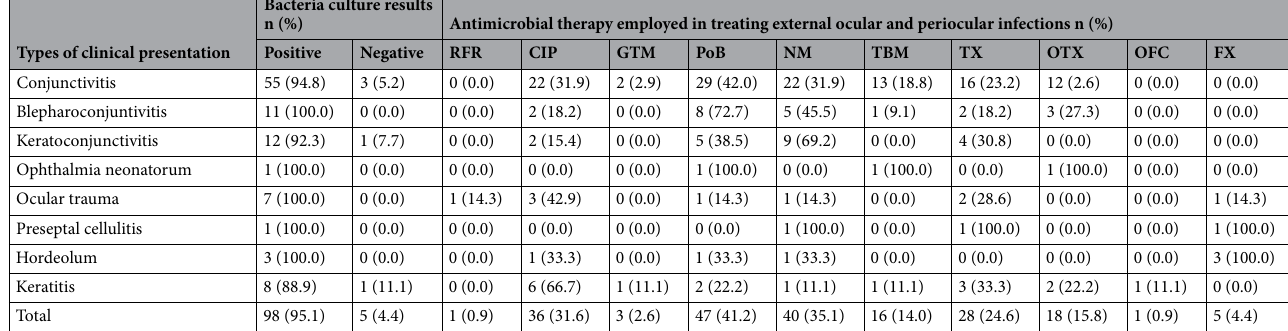
Table 3. Antimicrobial treatment of external ocular and periocular infections in a Ghanaian ophthalmic population. n frequency, % percentage frequency, RFR referral, CIP ciprofloxacin, GTM gentamycin, PoB